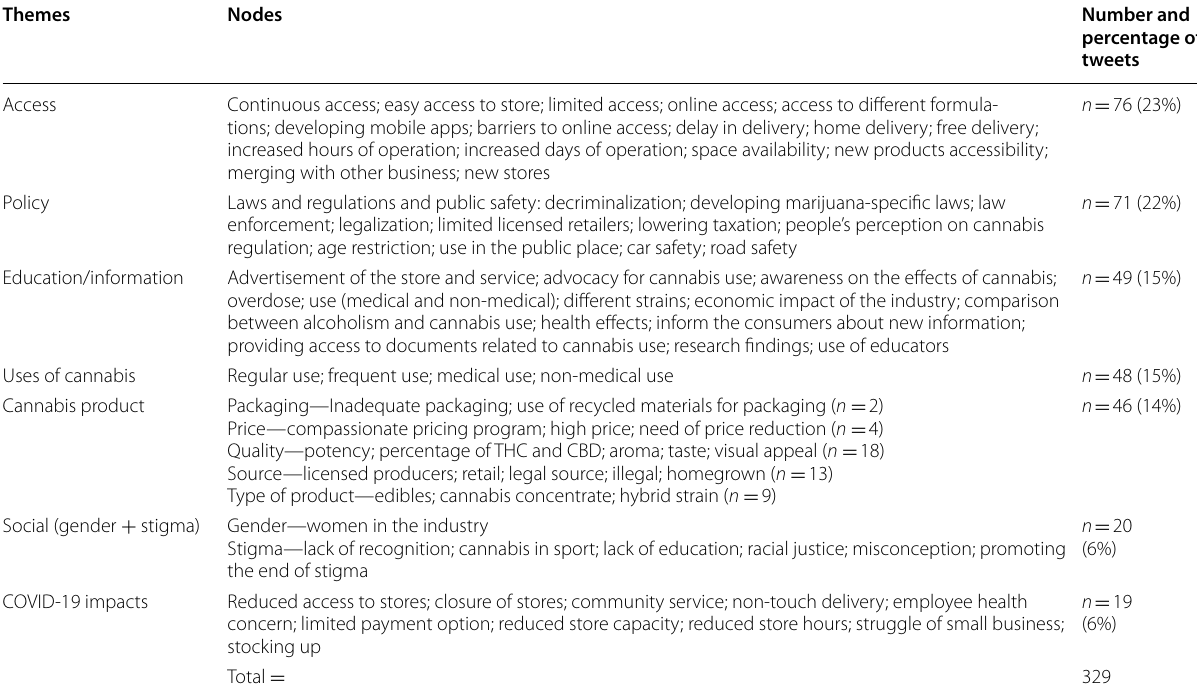
Table 2 Themes and nodes in licensed cannabis retailer Themes